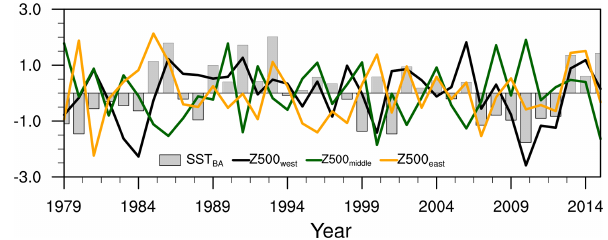
Figure 13. The variation of the November normalized SST BA (gray bar) and area-averaged geopotential height at 500hPa of the three anomalous centers (west: black, middle: green, east: orange) from 1979 to 2015, after